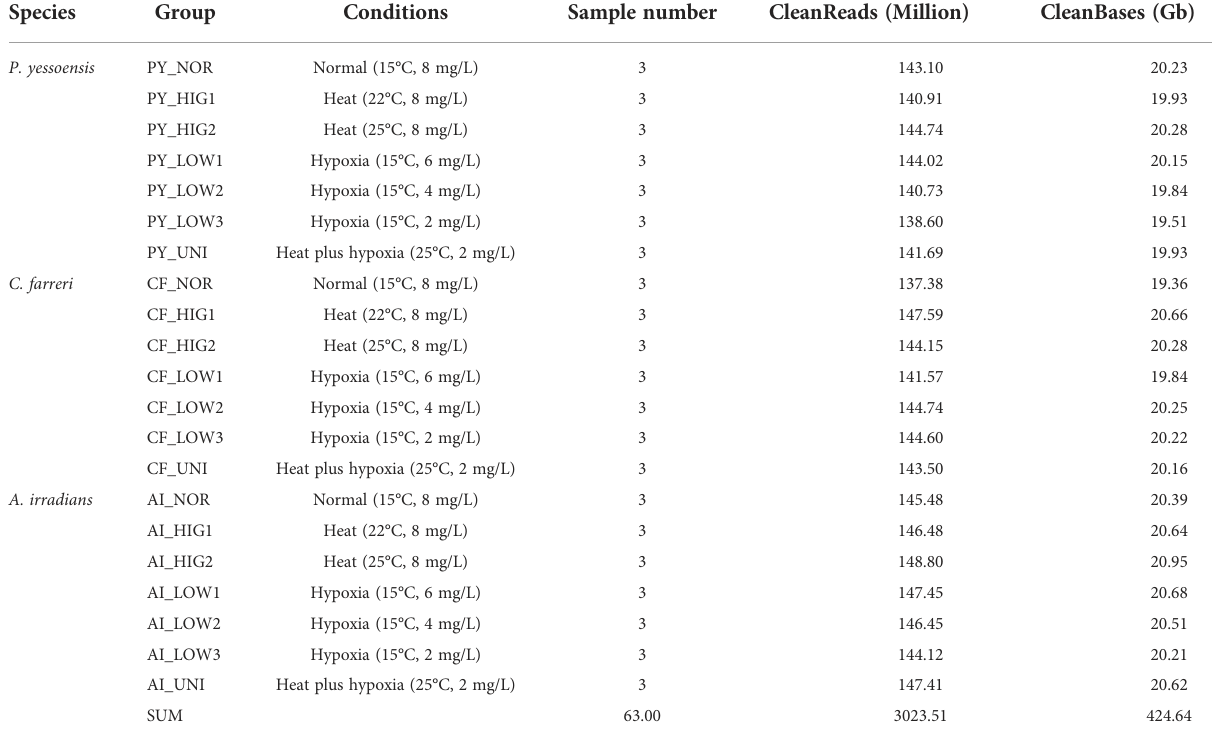
TABLE 1 Summary of transcriptome sequencing of scallop gill